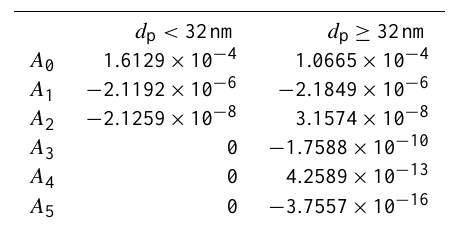
Table 2. Parameters for wall loss polynomial